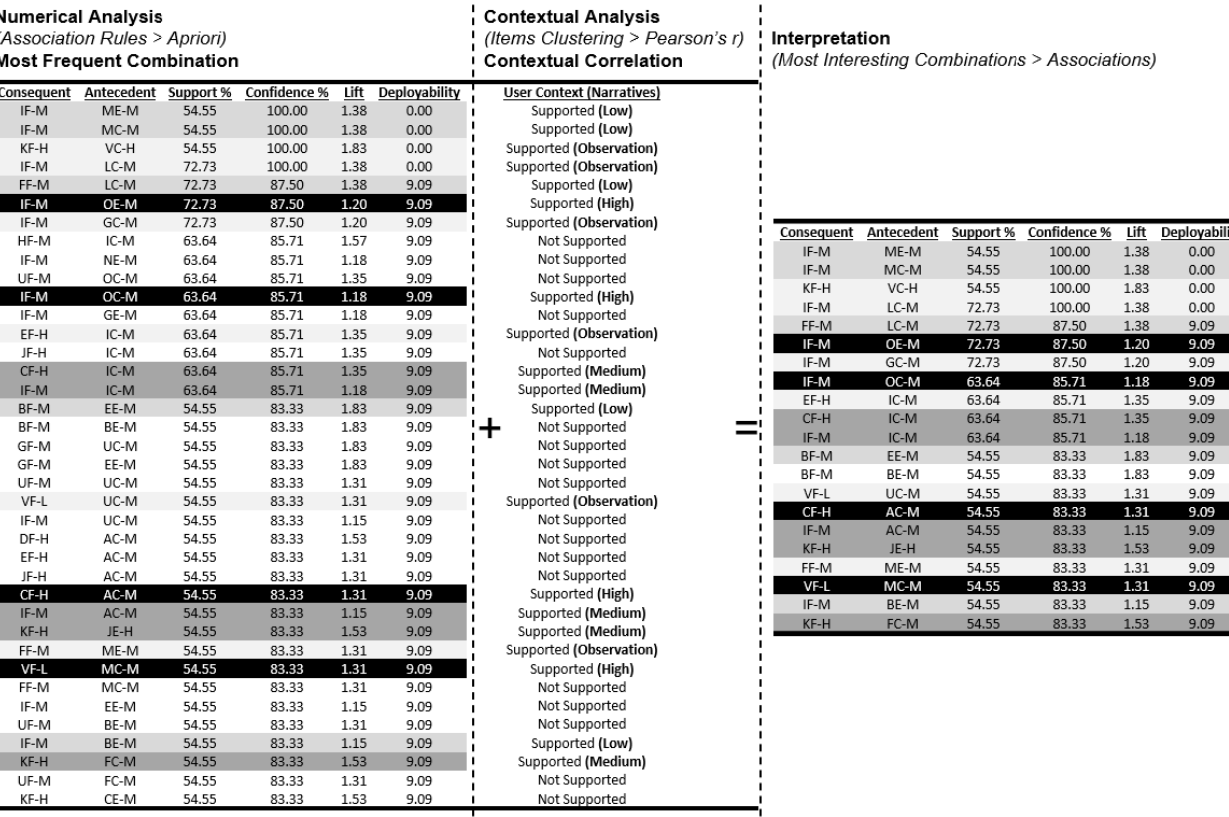
Figure 12. Most interesting combinations (interpretation) of spatial and environmental design factors. (Source: author).